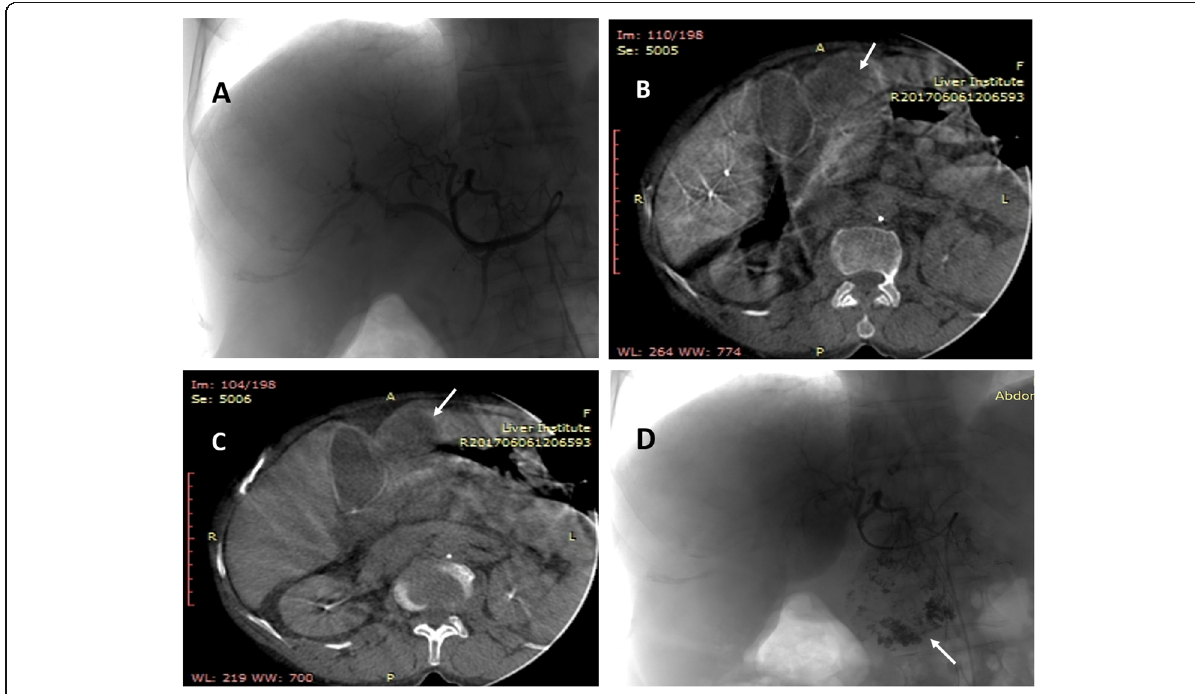
Fig. 4 A 68-year-old female patient diagnosed to have left lobe HCC focal lesions by laboratory and imaging criteria referred to do TACE. a Non- selective angiography of the main left hepatic artery revealing the vascular anatomy of the left hepatic artery with no detected focal lesions. b Axial CBCT-HA revealing left lobe mild peripherally enhancing focal lesion (arrow). c Axial CBCT-PV revealing wash out of contrast from the left lobe focal lesion (arrow). d Non-selective angiography of the main left hepatic artery post-lipiodol injection revealing concentration of lipiodol in the left lobe lesion (arrow) which was not shown in the angiography